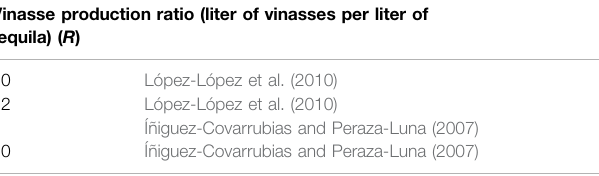
TABLE 2 | Vinasse production ratio used for the estimation of the TPUs vinasses production volumes. Vinasse production ratio (liter of vinasses per liter of tequila) ( R